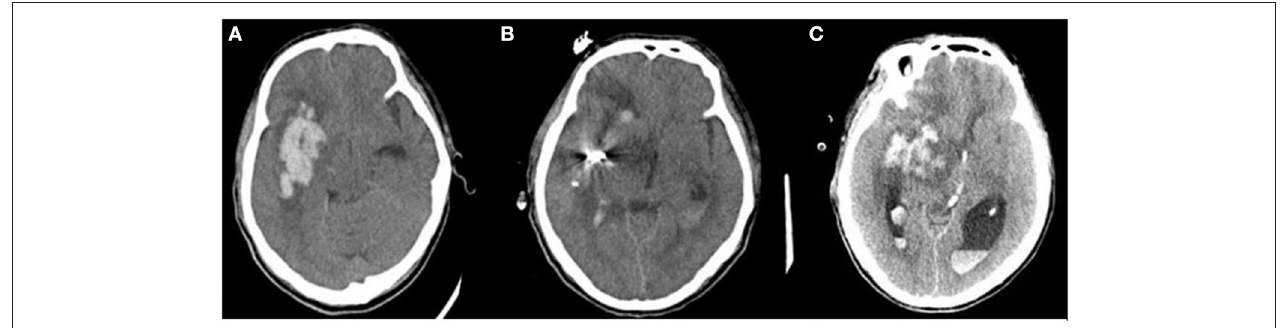
FIGURE 2 | Postoperative rehemorrhage in patients with ISH following sMIS. Postoperative rehemorrhage occurred in patients with irregular-shaped hematoma. (A) hematoma before surgery; (B) Hematoma size significantly decreased on the first postoperative follow-up CT scan; (C) Hematoma size increased on the second follow-up CT scan compared to the previous CT scan, suggesting postoperative